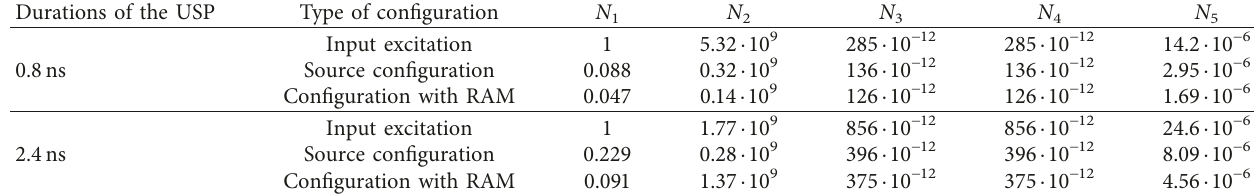
Table 4: N -norms for USPs of different